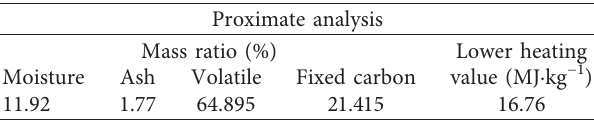
Figure 2: Three-dimensional mesh model of fluid in the Table 1: The proximate and ultimate analyses of China fir (air dry).